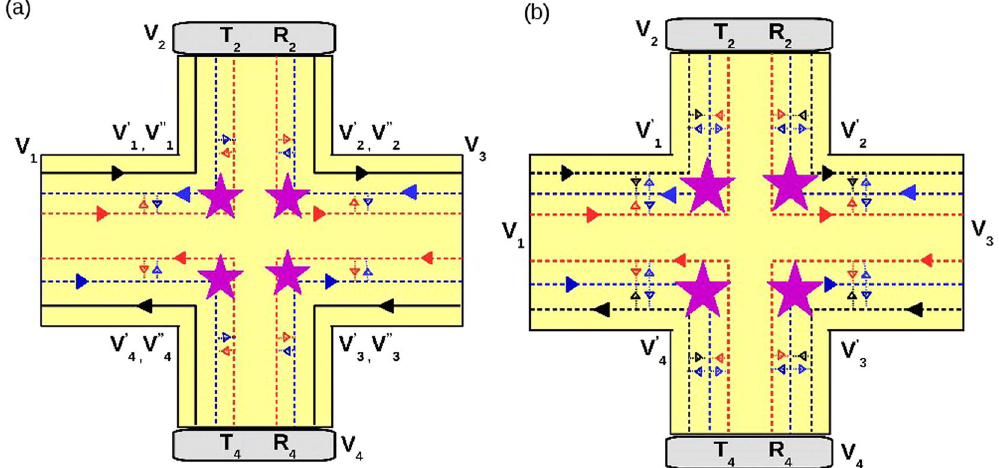
Figure 4. Four terminal QAH sample with disorder and inelastic scattering. ( a ) Chiral (topological) QAH edge mode with quasi-helical QSH edge modes in presence of inelastic scattering and disorder, ( b ) Chiral (trivial) QAH edge mode with quasi-helical QSH edge modes in presence of inelastic scattering and disorder.